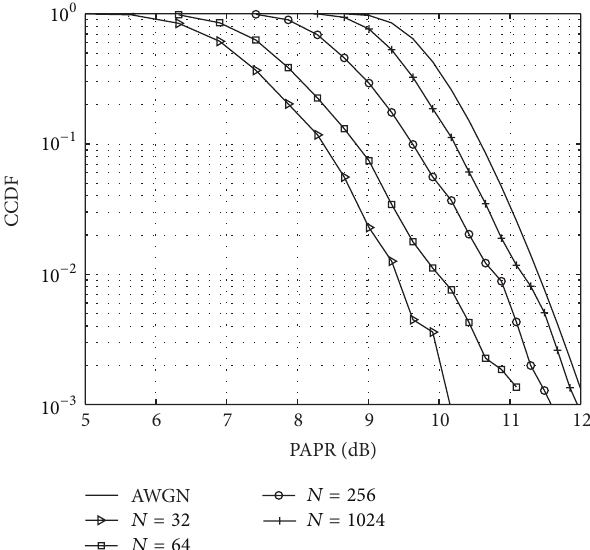
Figure 3: CCDF of the PAPR values of the FBMC symbols as a function of the number of